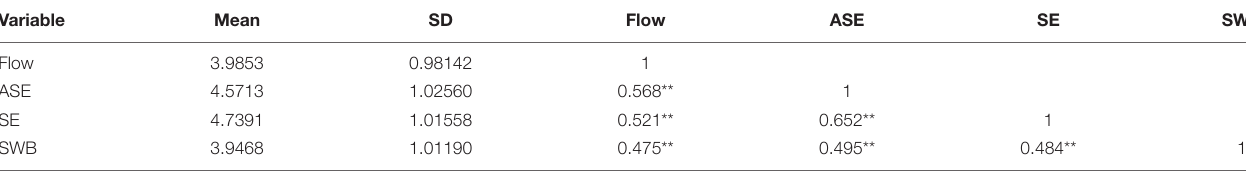
TABLE 2 | Descriptive statistics and correlational indices among variables.